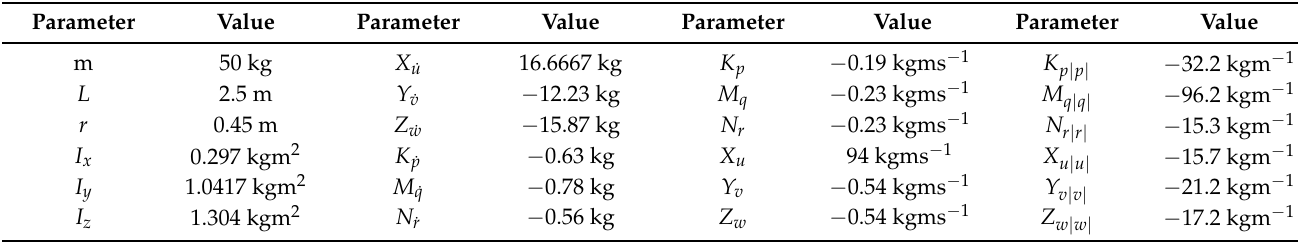
Table 1. Parameters of the